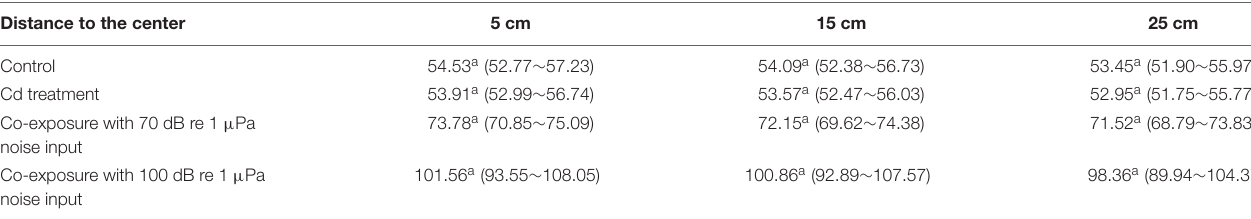
Significant differences at different positions of each experimental setup (data in the same line) are indicated by different superscripts.